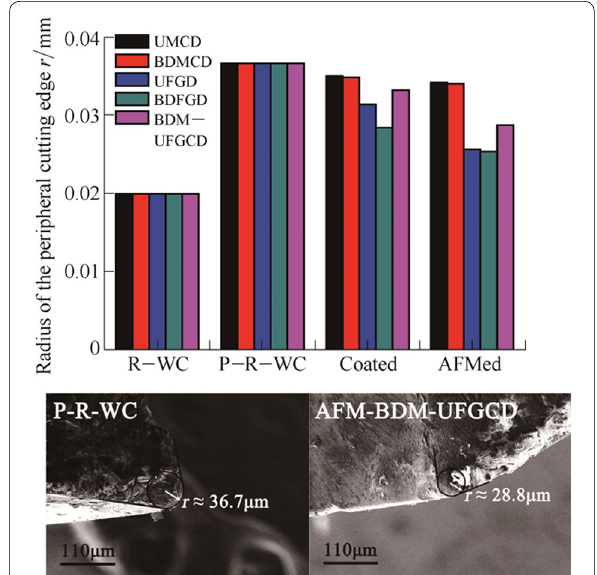
Figure 6 Radii of peripheral cutting edges of R‑WC milling cutters before and after the pretreatment, together with the five different diamond coated milling cutters before and after sufficient